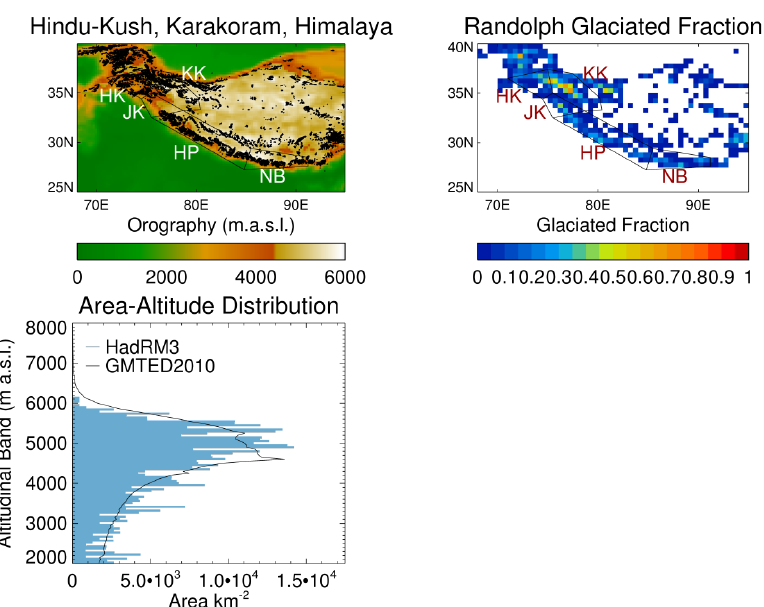
Figure 5. Location map of the Hindu Kush, Karakoram and Himalaya region showing the location of glaciers from the extended World Glacier Inventory (Cogley, 2010) (left), and the glaciated fraction aggregated to half degree from the Randolph glacier inventory (Arendt et al., 2012) (right). Also shown is the area–altitude distribution as used in the RCM and from the high-resolution GMTED10 (Danielson and Gesch, 2011) product. Highlighted are the Hindu Kush (HK), Karakoram (KK), Jammu–Kashmir (JK), Himachal Pradesh, Uttarakhand and West Nepal (HP) and East Nepal and Bhutan (NB) sub-regions used in this study.